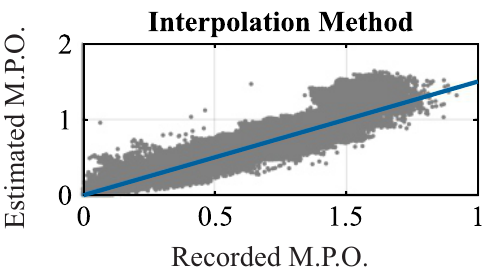
Figure 5. Maximum power output (M.P.O.) estimated by the interpolation method recommended by IEC 61853-3 versus those recorded for the PV modules under study. Both are normalized concerning the respective rated powers of the PV